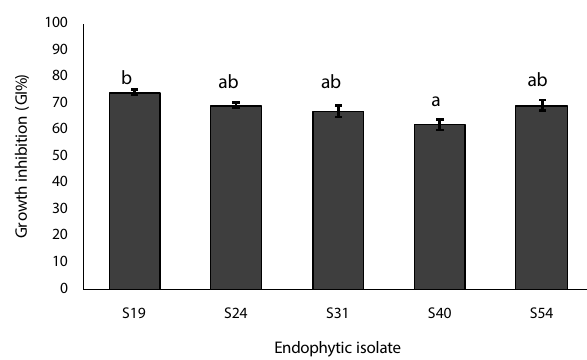
Figure 2. Growth inhibition rates of the endophytic bacteria toward Phytophthora citrophthora . Growth inhibition values followed by different letters are significantly different (Tukey Test, P < 0.05, n = 6, (± standard errors)).